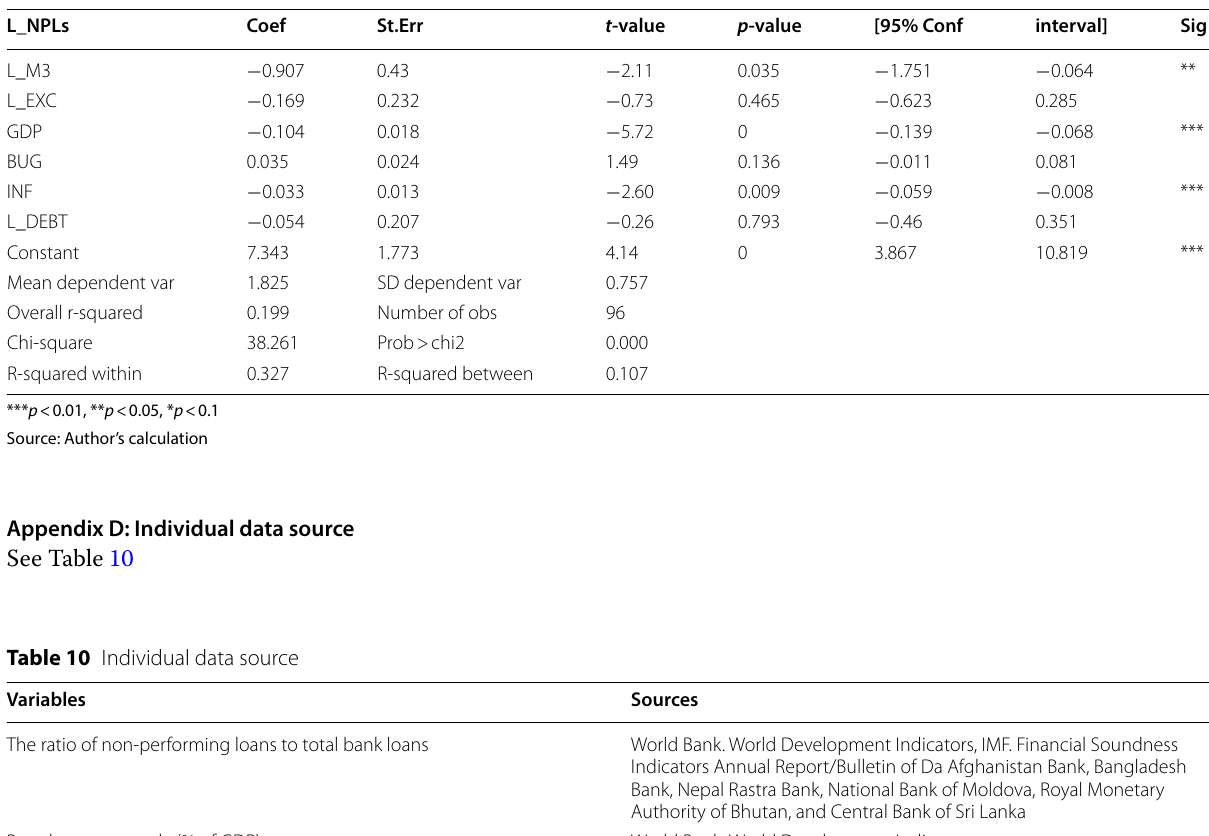
Table 9 Random effect estimation